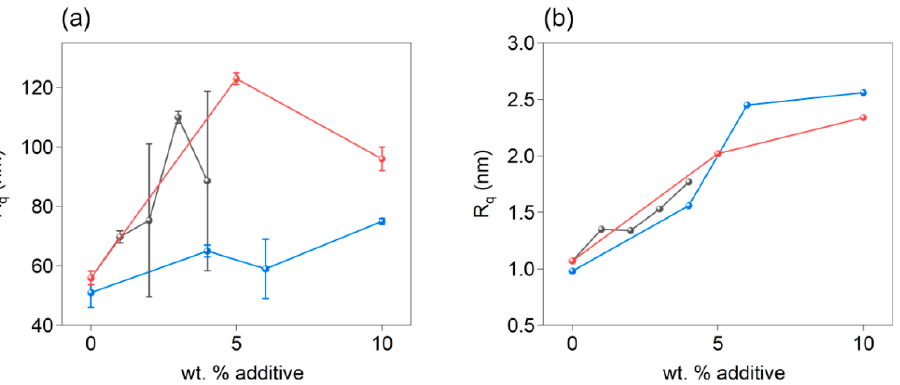
Figure 6. ( a ) Thickness and ( b ) roughness (R q ) of thin films of PEDOT:PSS with EG (black data), G (blue data), and G+DMSO (red (blue data), and G+DMSO (red data).